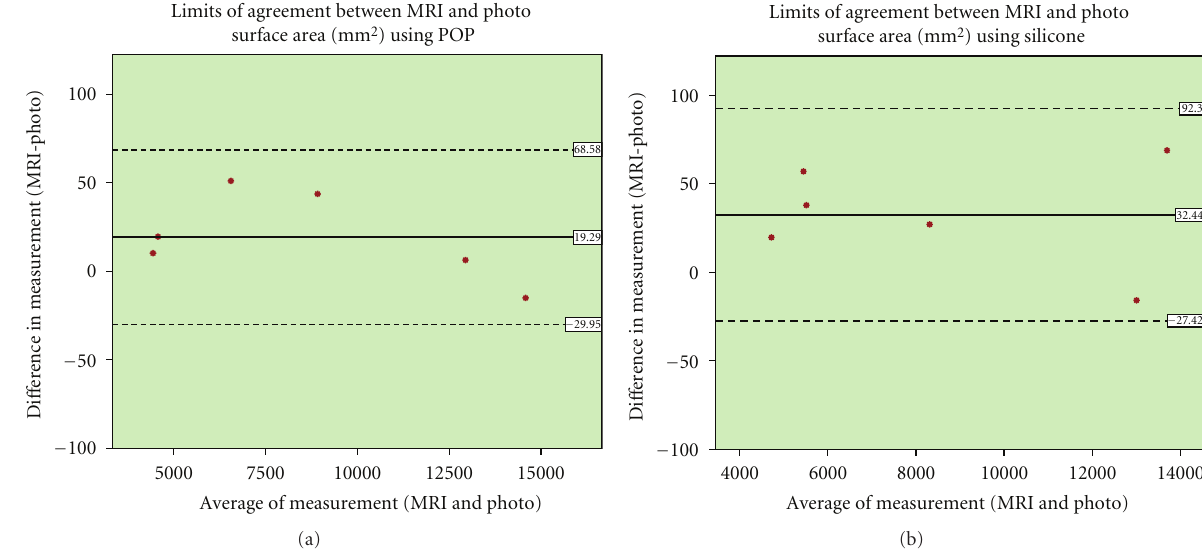
Figure 8: Bland and Altman plot for the surface area measurement comparison of MRI and photo, (a): POP and (b): silicone.